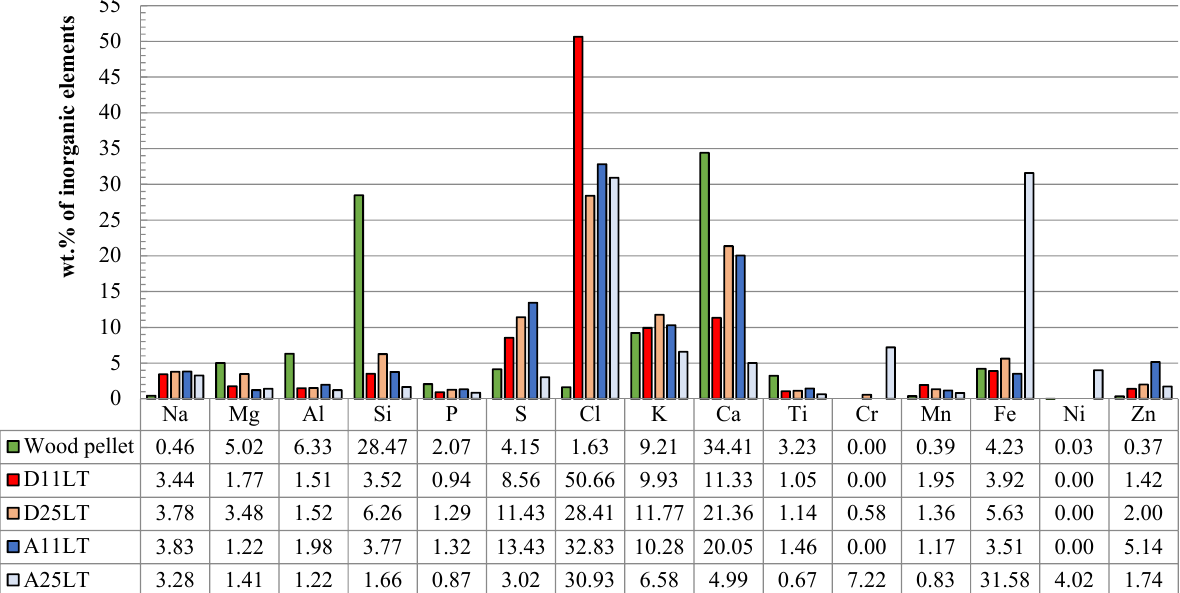
Figure 6. Comparison of inorganic elements present in wood pellet and fouling